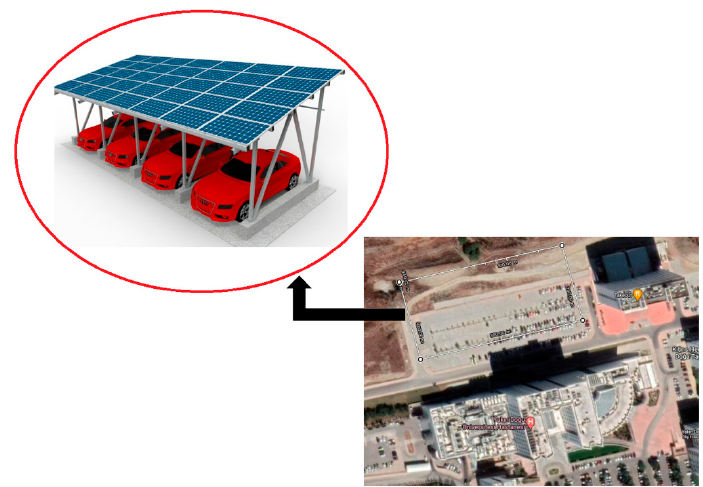
Figure 6. Location of the car park at Near East University.